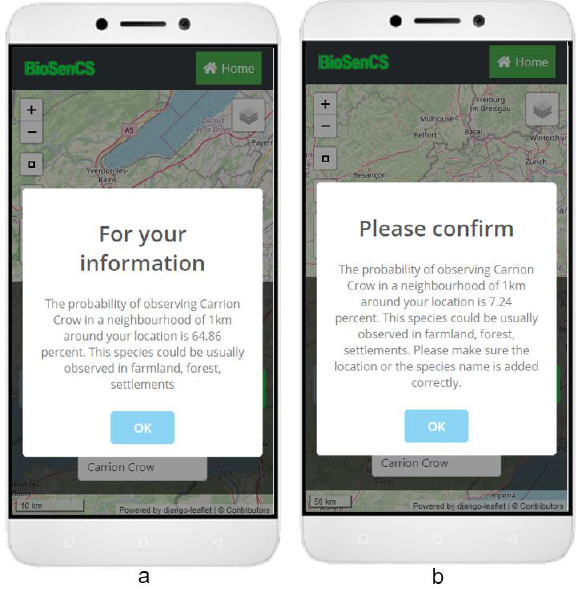
Figure 11. Location feedback if probability of occurrence of species is higher (a) and lower (b) than 50